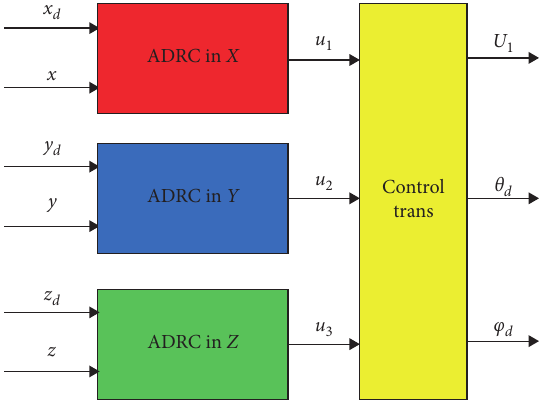
Figure 6: Position controller structure diagram.